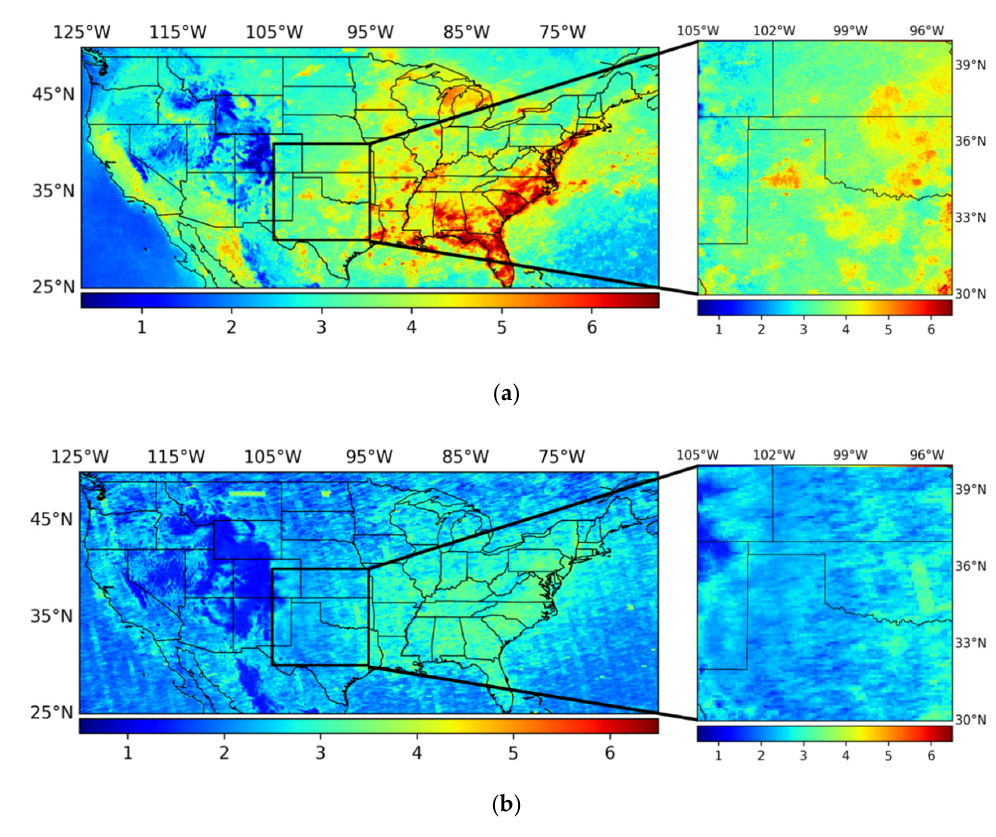
Figure 14. ( a ) Average surface distribution of HCHO over the U.S. in July 2019, derived from Sentinel-5P data; ( b ) Average surface distribution of HCHO over the U.S. in July 2019, derived from OMI data (unit: μ g/m 3 ).